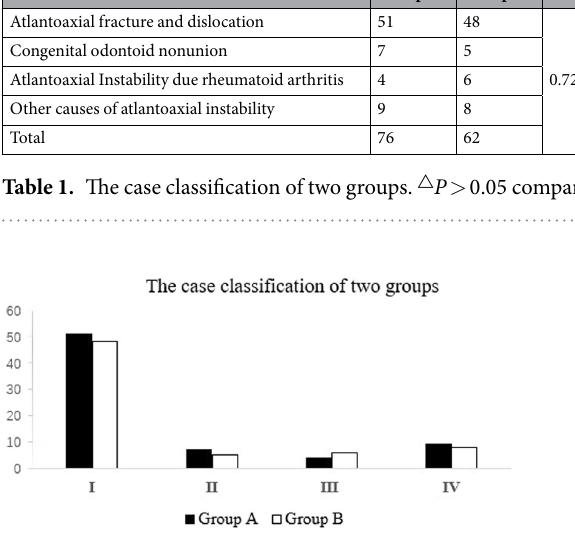
Figure 1. (I) Atlantoaxial fracture and dislocation. ( II) Congenital odontoid nonunion. (III) Atlantoaxial Instability due rheumatoid arthritis. (IV) Other causes of atlantoaxial